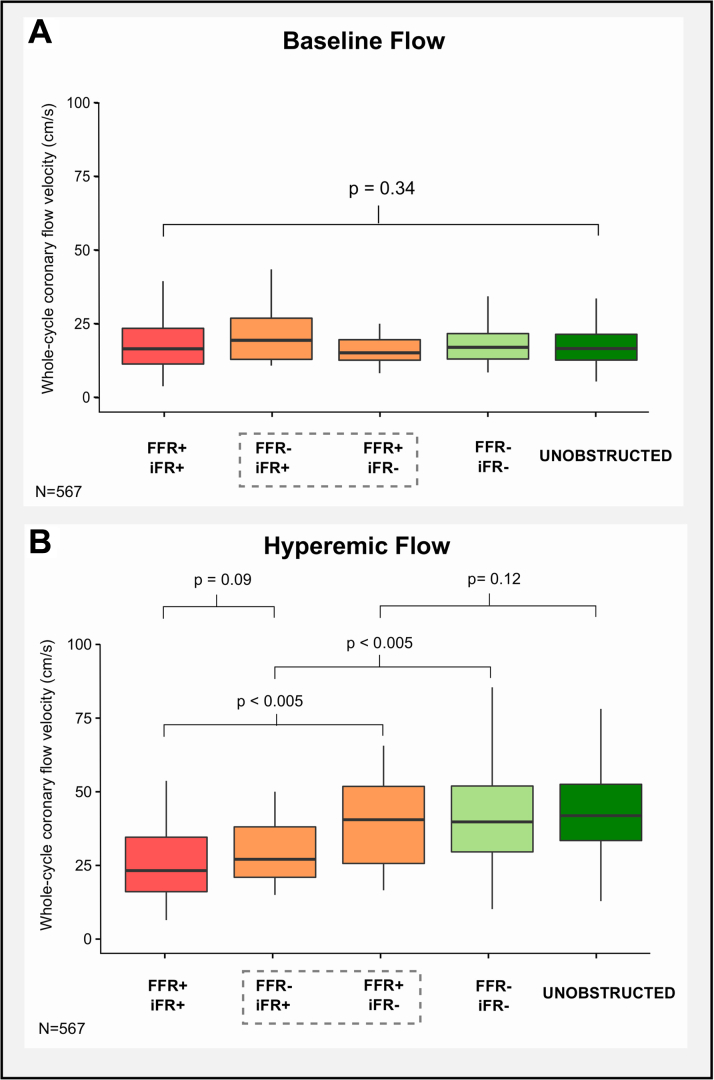
Boxplot Comparisons of Baseline and Hyperemic Coronary Flow VelocityThe horizontal black line indicates the median value. The box indicates the interquartile range and the whiskers indicate the range of values. FFR+/iFR+ (n = 108) cases are colored red. FFR–/iFR+ (n = 28) and FFR+/iFR– (n = 22) discordant cases are colored orange. FFR–/iFR– (n = 208) cases are colored light green. Unobstructed reference vessel (n = 201) cases are colored dark green. (A) Baseline coronary flow velocity was similar across all groups. (B) Hyperemic coronary flow velocity was similar in FFR+/iFR+ and FFR–/iFR+ groups. Hyperemic coronary flow velocity was similar in FFR+/iFR–, FFR–/iFR– and unobstructed reference vessel groups. Abbreviations as in Figure 1.